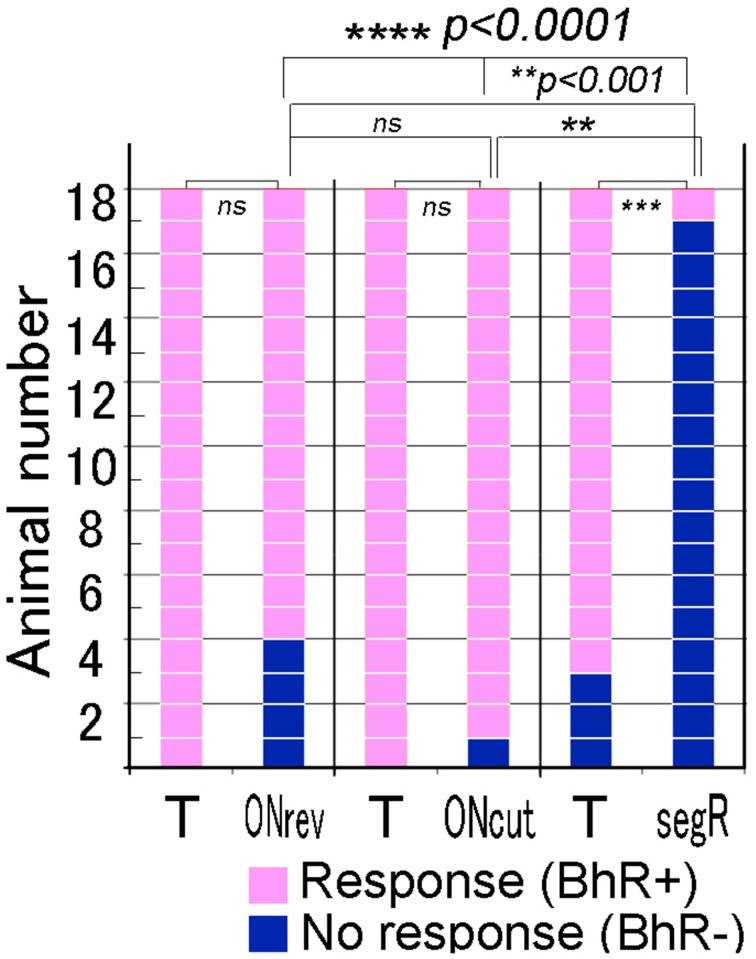
Performance of individual animals tested for discrimination of the test sounds modified in fine temporal structure. For the temporal test sounds, temporal structure of the CS is disturbed fully (segR), partially (ONrev) or only at the onset attack portion (ONcut). The target (T) sound (i.e., CS) is also played within each test trial and used as the positive control. Squares in pink indicate positive reactions, while those in dark blue indicate no reaction. #p < 0.05; *p < 0.005; **p < 0.001; ***p < 0.0005, ****p < 0.0001, and ns: p > 0.05.